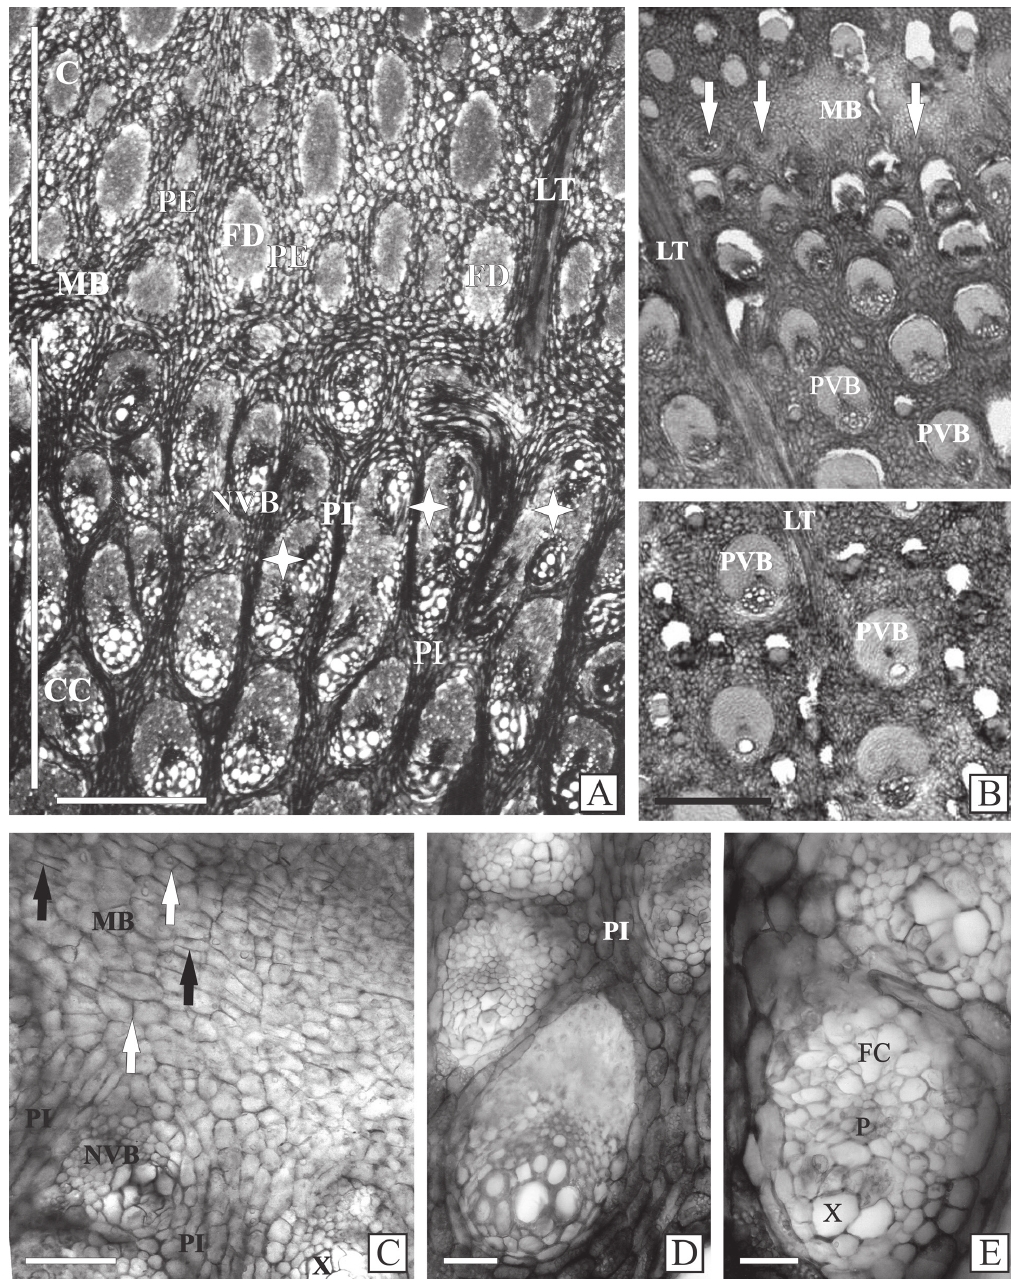
Figure 4 - A - E. Transverse sections. A, C - E. Butia paraguayensis a short stem. B. Syagrus petraea , a subterranean stem. A. Detail of the interface between the cortex and the central cylinder, showing the meristematic band and mature tissues derived from it: new vascular bundle, differentiated fiber strand, secondary external and internal parenchyma. The asterisks show the anastomose of the secondary vascular bundles. B. See the meristematic band with the newly formed secondary vascular bundles (arrows). C. Detail of the meristematic band showing recently divided cells with periclinal walls (black arrows) and anticlinal walls (white arrows). D. Detail of differentiating new vascular bundles. Note that the lower vascular bundle is almost mature. E. Detail of two immature new vascular bundles. AB: axial bundle, FC: fiber cap, FD: differentiated fiber strand, MB: meristematic band, P: immature phloem, PE: secondary external parenchyma cells, PI: secondary internal parenchyma cells, PVB: primary vascular bundle, LT: leaf trace, NVB: new vascular bundle; X: immature xylem. Scale bars: 50 µm (A - E)